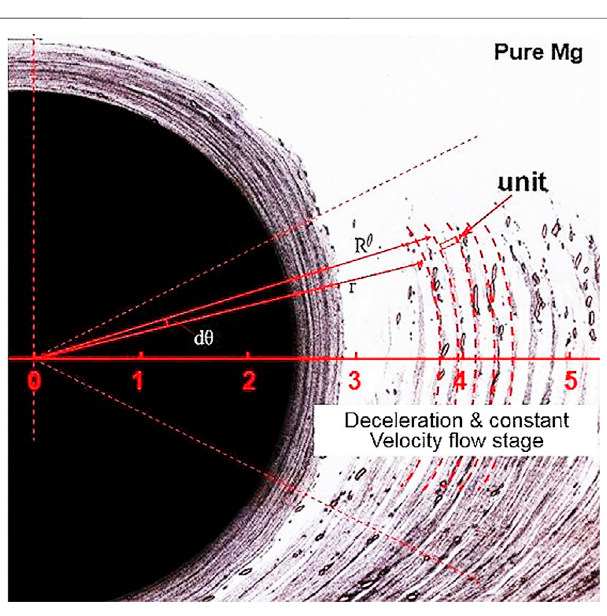
FIGURE 6 | Deceleration and constant velocity fl ow stage.